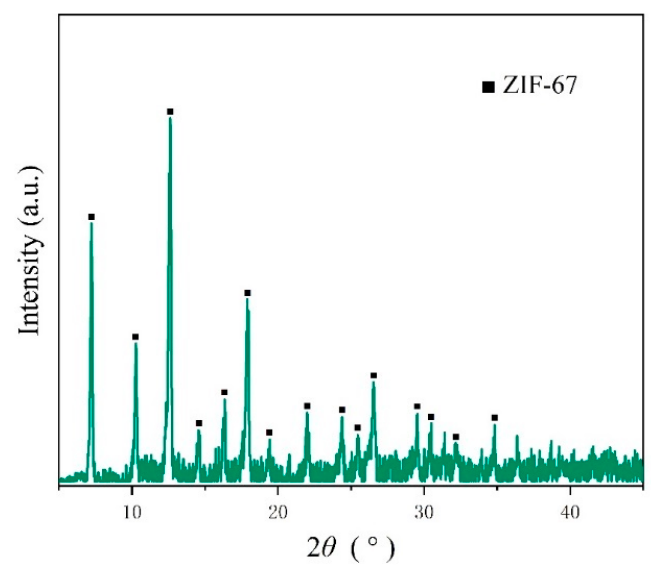
Figure 4. The XRD spectrogram.